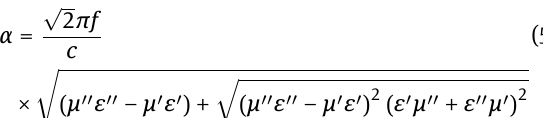
The value of the attenuation constant α represents the strength of the material’s ability to lose electromagnetic waves. The larger the value of α , the stronger the material’s ability to absorb electromagnetic waves. α obeys the fol- lowing formula [45,